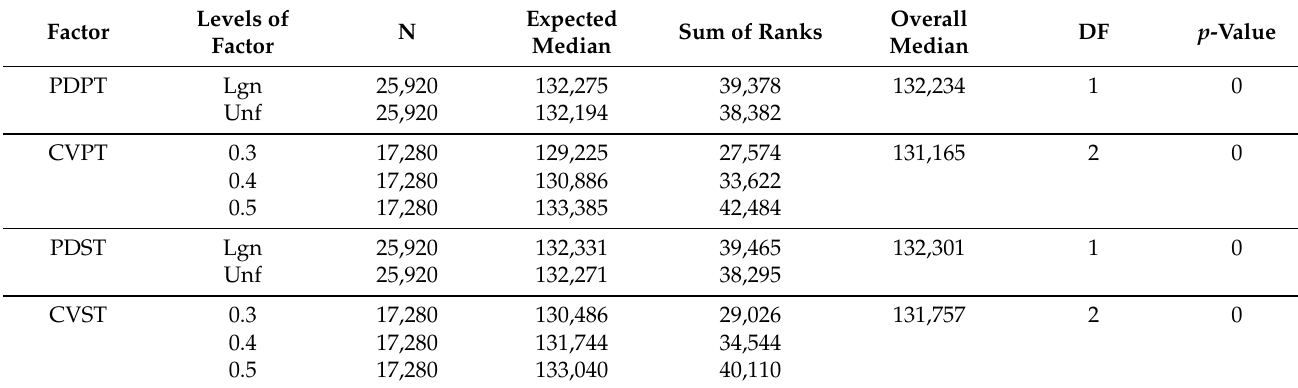
Table 9. Friedman test for E[E/T] versus the factors PDPT, CVPT, PDST, and CVST.